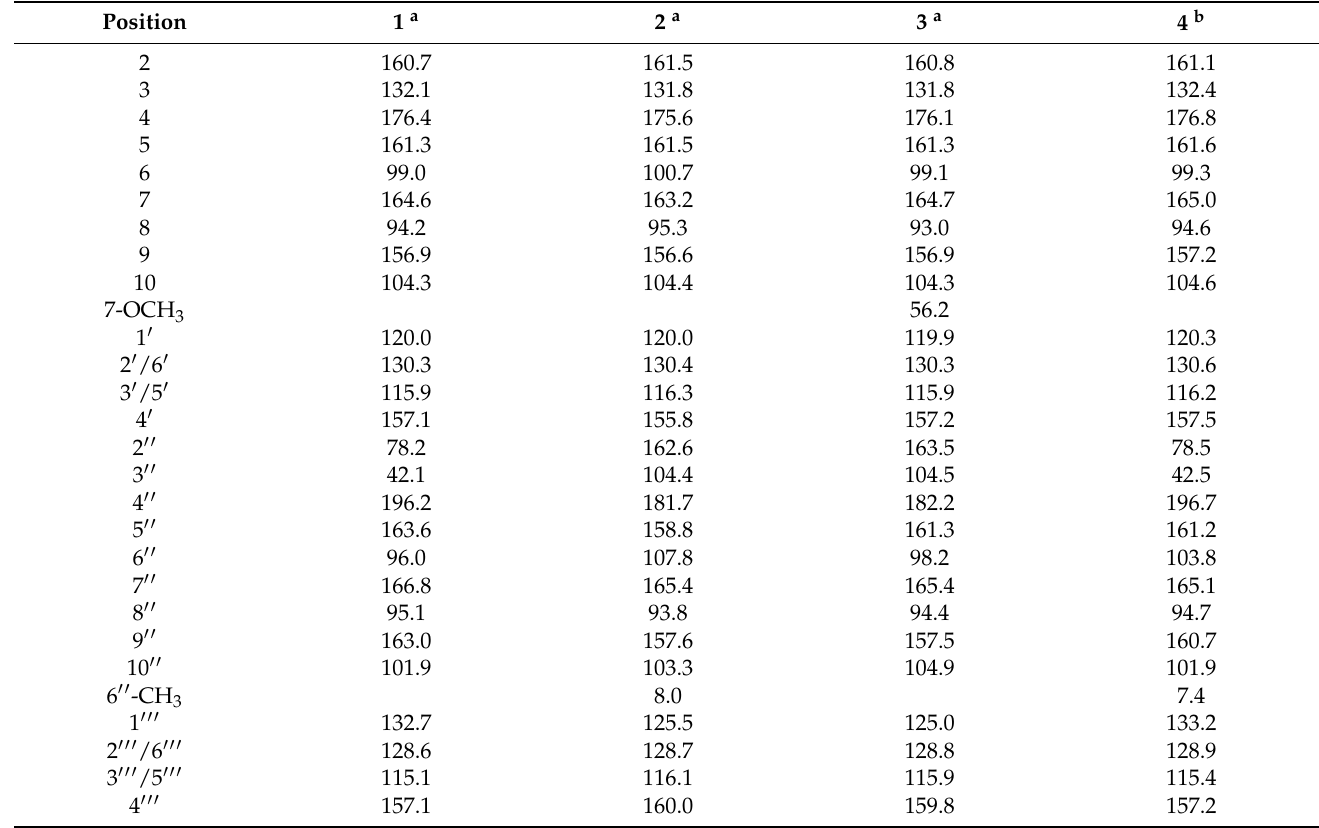
Table 2. 13 C NMR spectral data for compounds 1 – 4 in DMSO- d 6